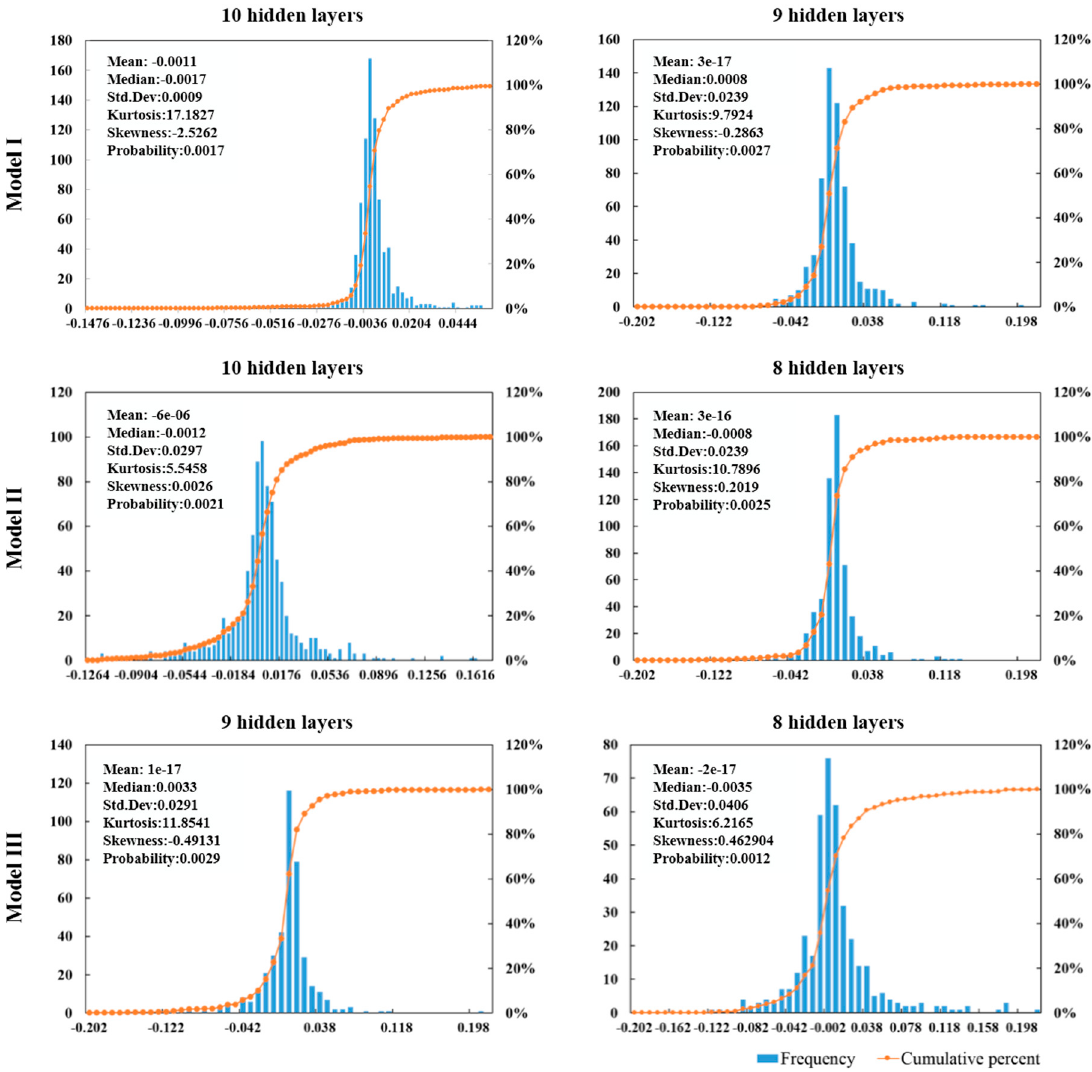
Figure 6. The residual frequency histograms and residual cumulative percent plots of three groups of optimal models.